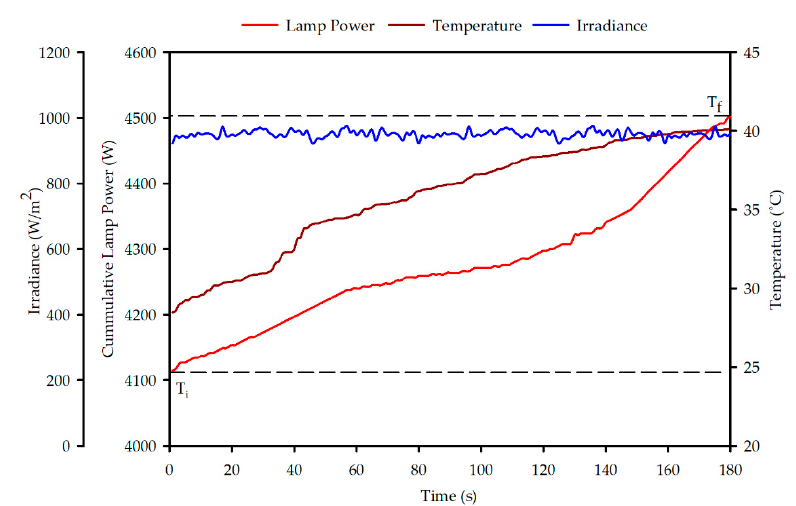
Figure 11. Cumulative power generated by the solar simulator.